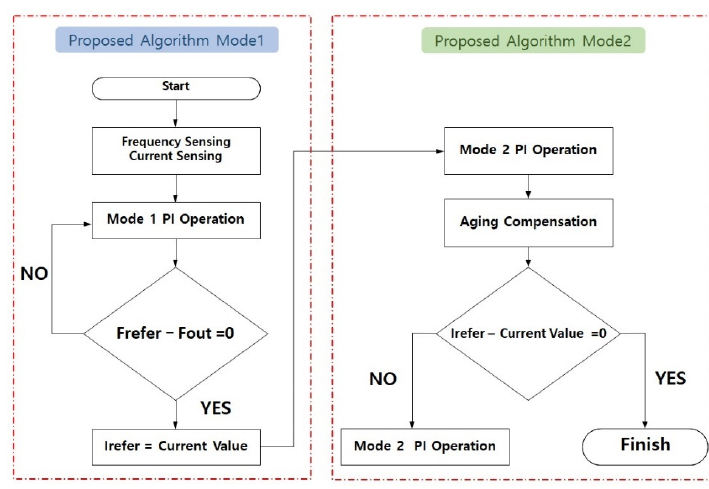
Figure 4. Mode switching algorithm for LED module calibration.